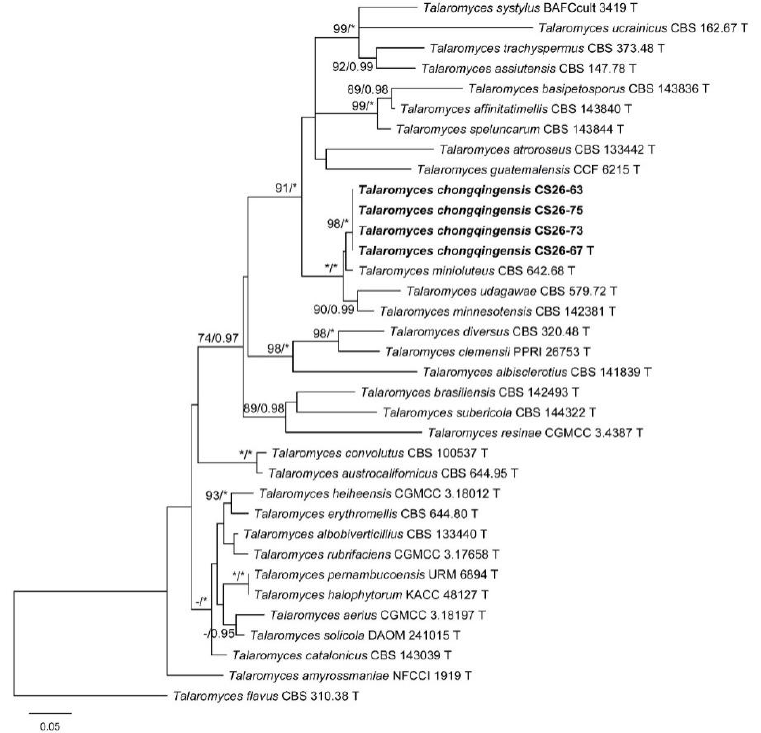
Figure 1. Maximum likelihood phylogeny of Talaromyces sect. Trachyspermi inferred from the BenA dataset. Bootstrap values ≥ 70% ( left ) or posterior probability values ≥ 0.95 ( right ) are indicated at nodes. Asterisk denotes 100% bootstrap or 1.00 posterior probability.